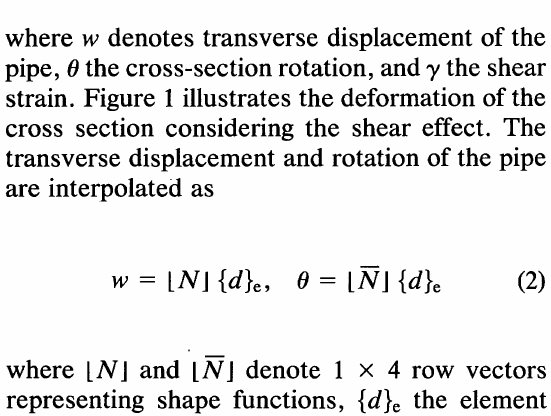
FIGURE 1 Deformation of the cross section consid ering shear